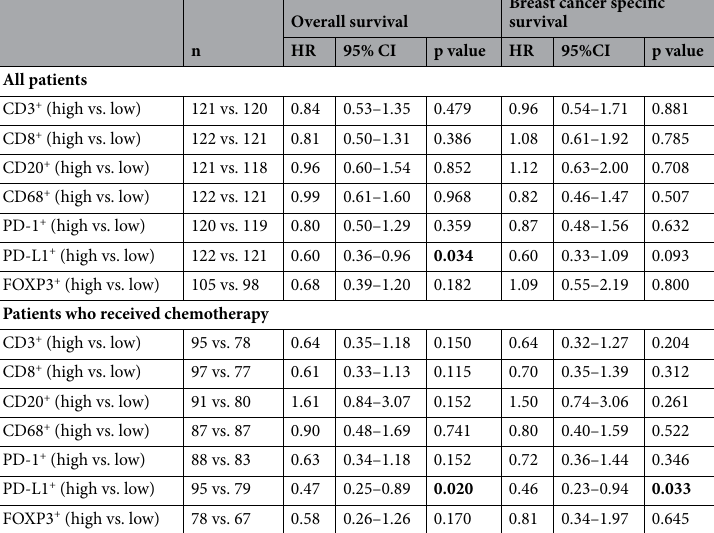
Table 2. Survival analysis of all single markers for overall survival and breast cancer-specific survival in all patients and in those who received chemotherapy.